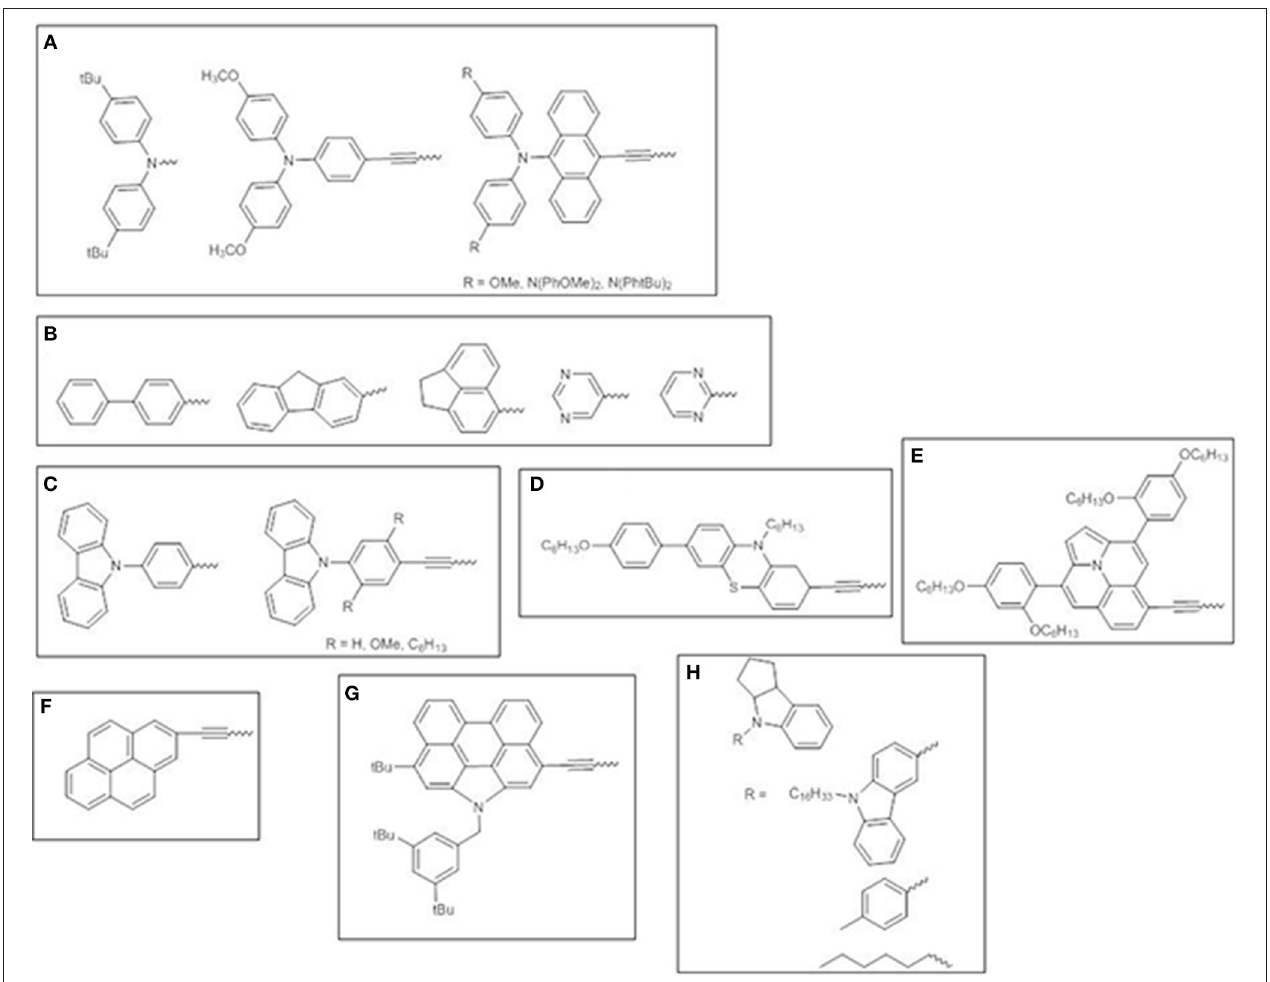
FIGURE 11 | Various electron-donor moieties used for trans -A 2 BC push-pull Zn II porphyrins. (A) arylamines; (B) polyaromatic or heterocyclic groups; (C) carbazole; (D) phenothiazine; (E) ullazine; (F) pyrene; (G) N-annulated perylene; (H) indoline-conjugates.